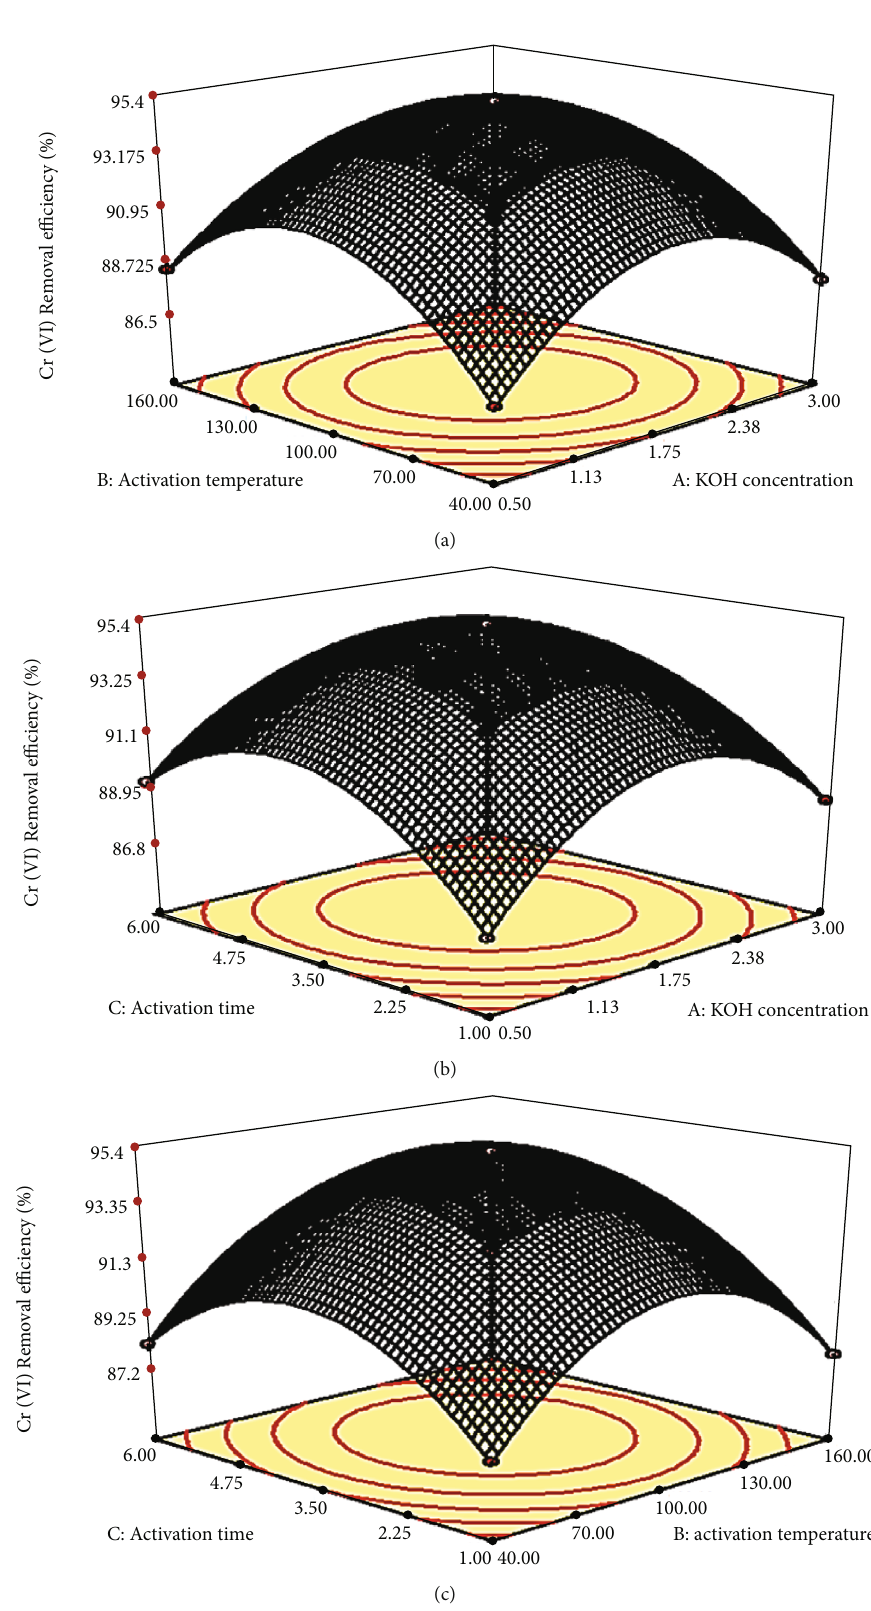
Figure 7: Surface plots of base-treated Te ff straw biosorbent for Cr (VI) removal e ffi ciency: (a) KOH concentration vs. activation temperature, (b) KOH concentration vs. activation time, and (c) activation temperature vs. activation